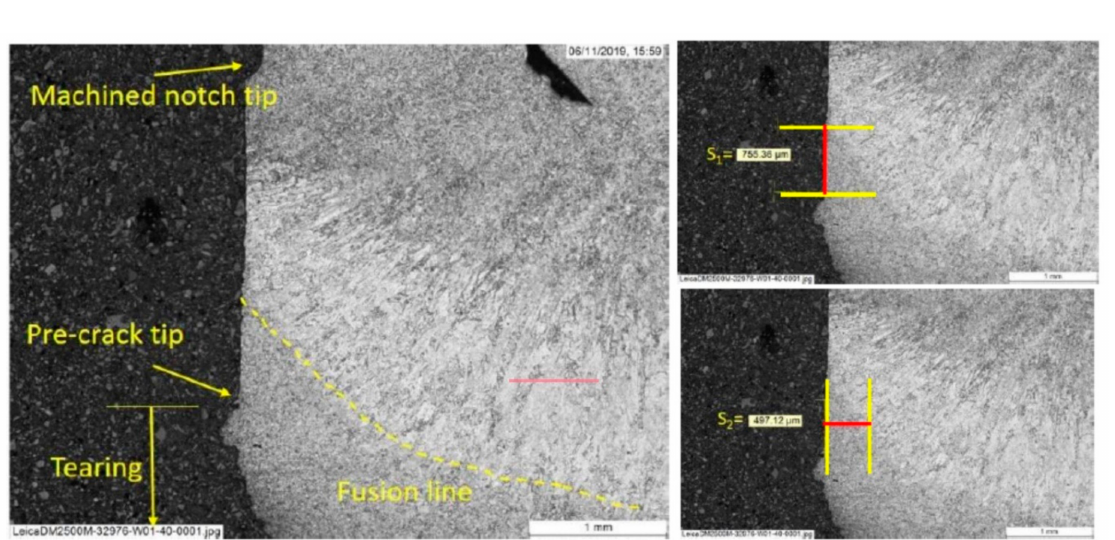
Figure 11. Example of post-test metallography from specimen W01-40, characterizing the distance of the crack tip from the fusion line, in terms of s1 and